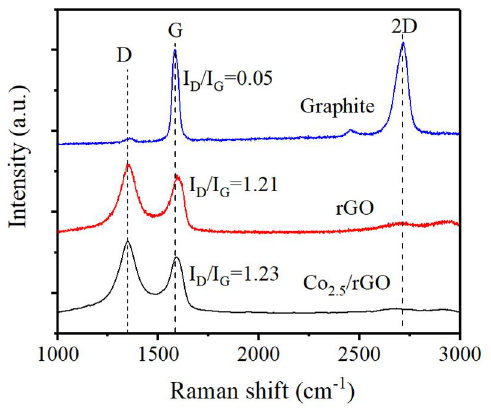
Figure 3. Raman diagrams of graphite, rGO, and Co 2.5 /rGO catalyst.